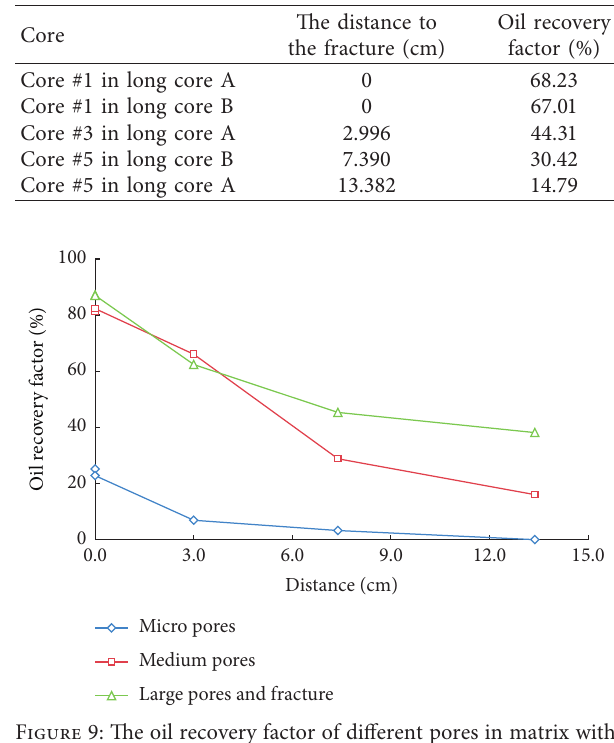
Figure 9: The oil recovery factor of different pores in matrix with different distances to the fracture.